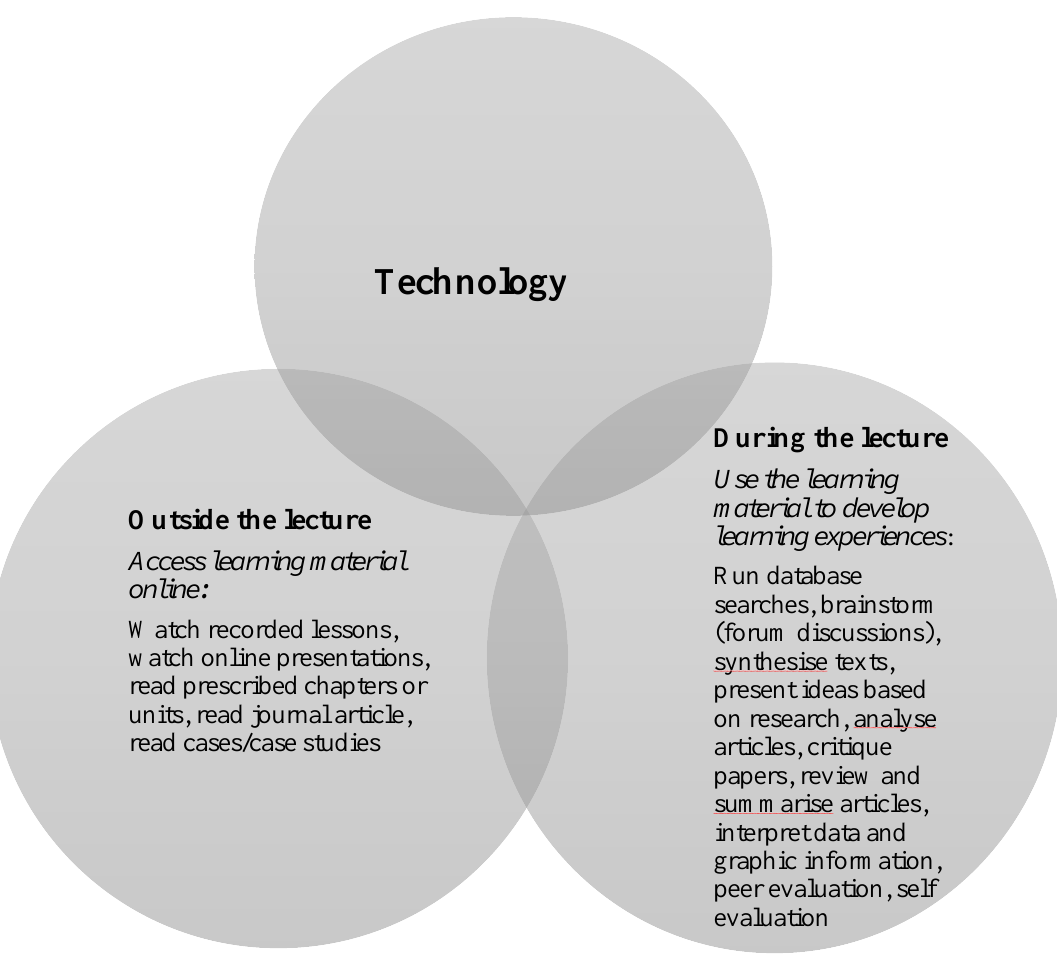
Figure 7. Technology-assisted instructional